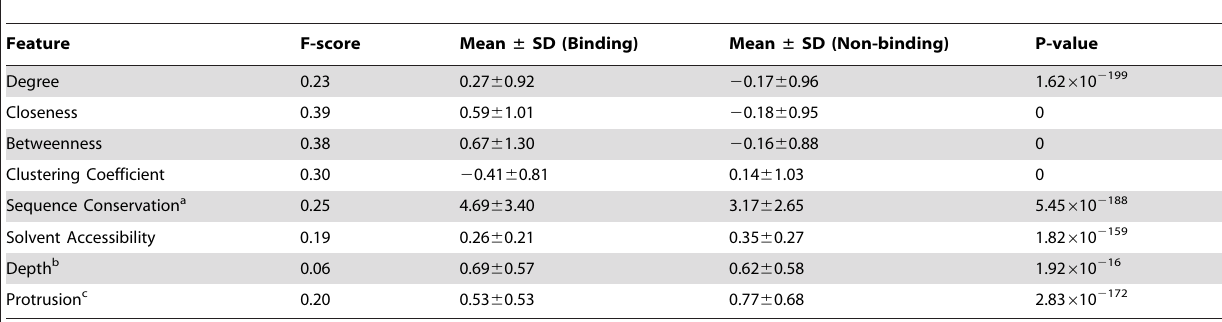
Table 2. Comparison of the potential predictive capability of different features.